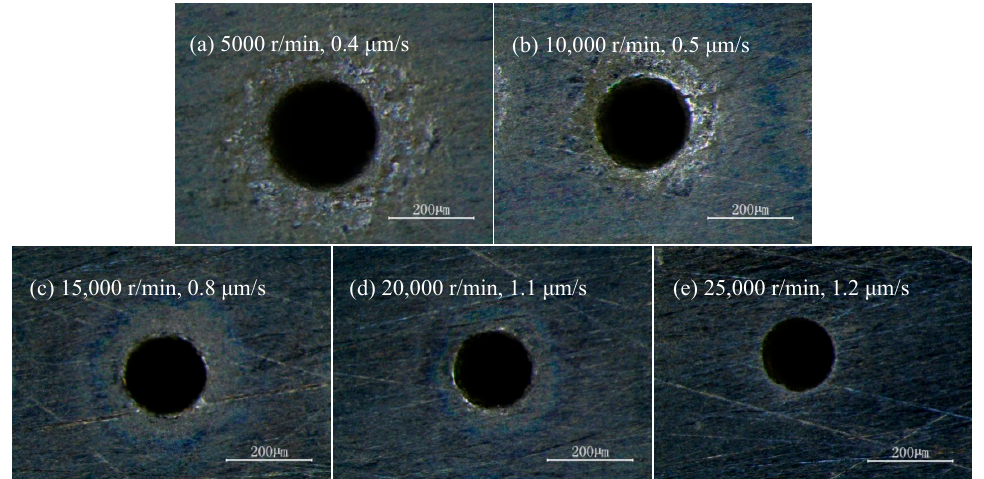
Figure 7. Results at the different rotating speed and the maximum feed rate.